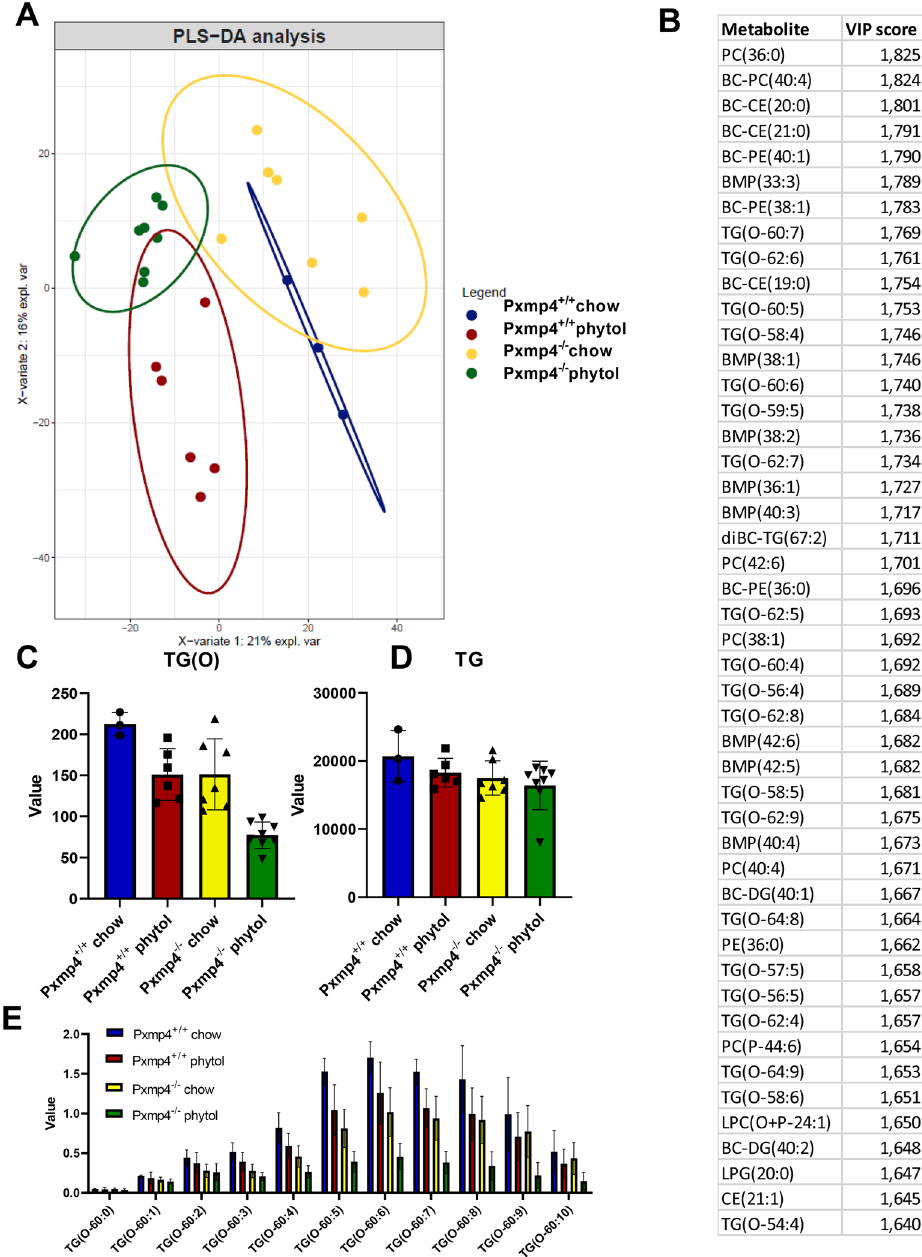
Figure 5. Effect of PXMP4 deficiency and phytol supplementation on the hepatic lipidome. ( A ) Partial Least Square (PLS) regression analysis; ( B ) Most important changed lipid species based on PLS-derived VIP scores; ( C ) Effect of PXMP4 deficiency and phytol supplementation on total hepatic TG levels; ( D ) Effect of PXMP4 deficiency and phytol supplementation on total hepatic TG(O) levels; ( E ) Effect of PXMP4 deficiency and phytol supplementation on the hepatic abundance of TG(O-60)